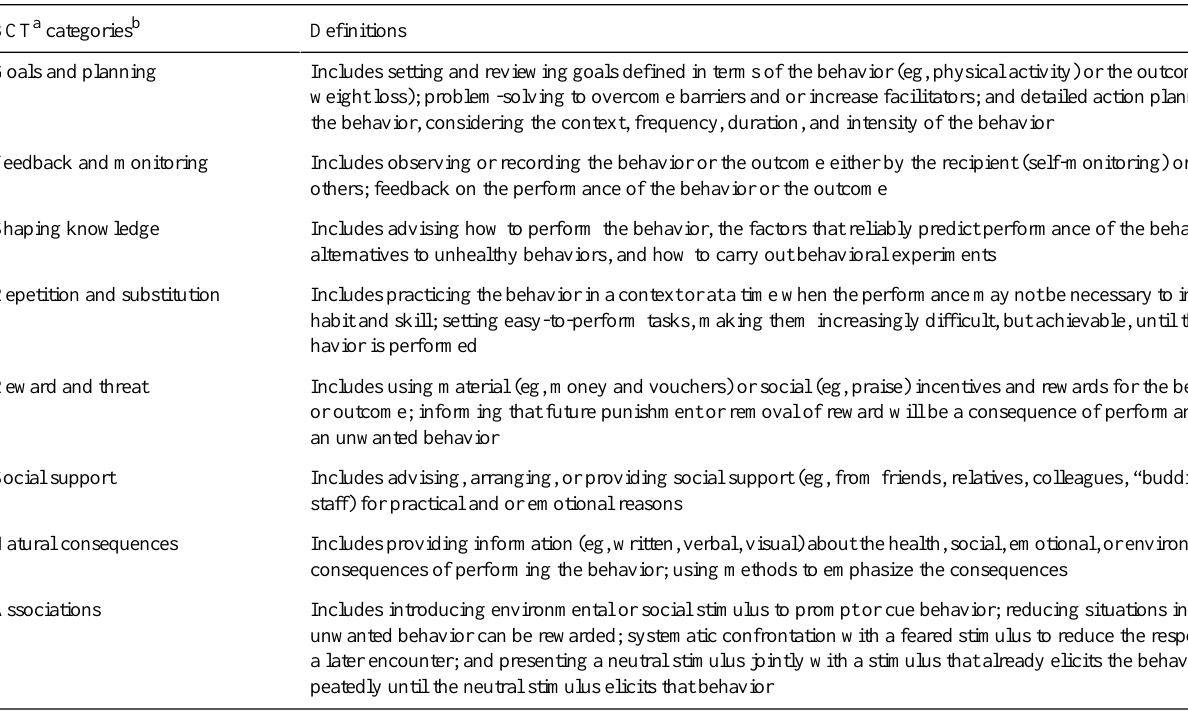
Table 4. Definitions of behavior change